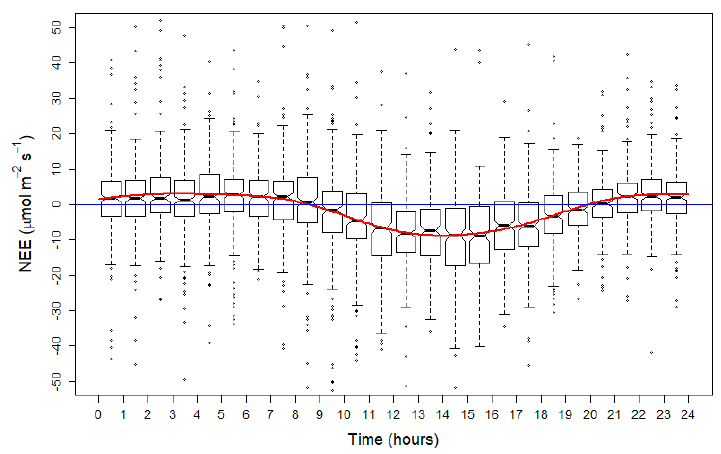
Figure 2. Values of net ecosystem exchange (NEE, µmol m −2 s −1 ) over the study period (June to September, 2014) on a 24-h timescale. Red line describes smooth mean of the NEE. Carbon fluxes were sensitive to temperature and precipitation over the study period.